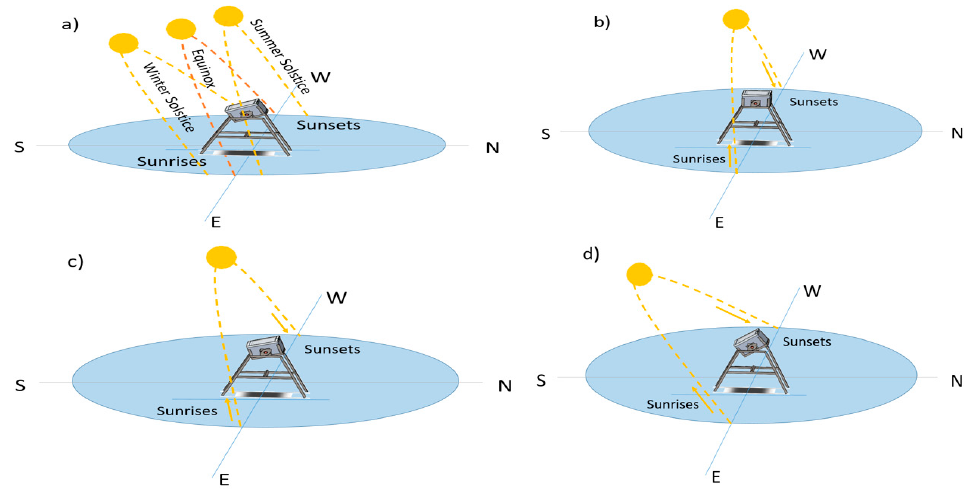
Figure 2. Representation of CPC tilting ( a ) Static setup 21°; ( b ) summer 0°; ( c ) spring/autumn 16°; and ( d ) winter 32°.